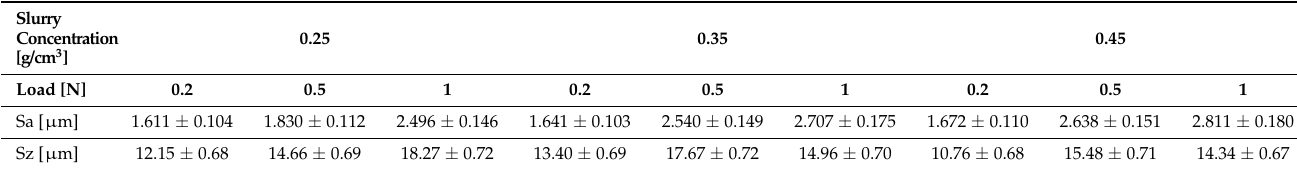
Table 2. Results obtained from the amplitude parameters (Sa and Sz) in the height deviation of the topography of the craters. Surface texture ISO 25178; Height parameters ( μ m).